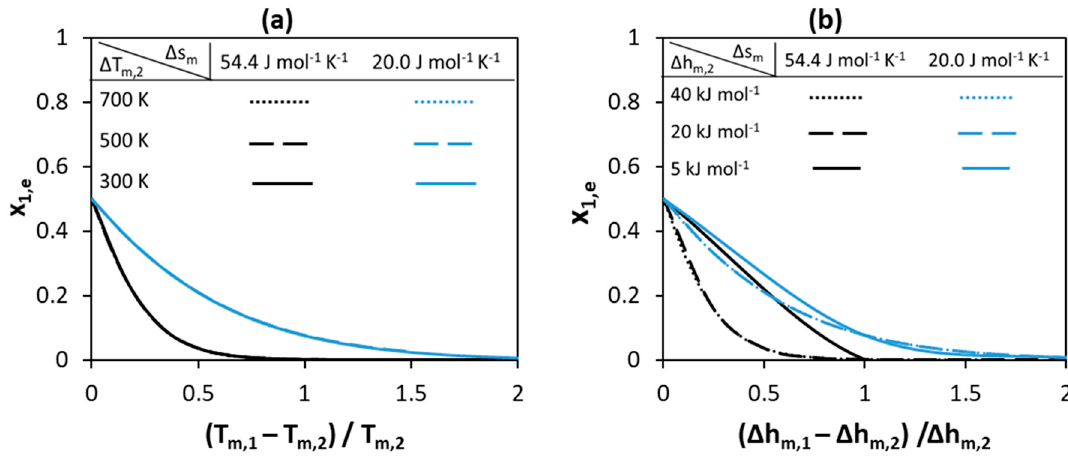
Figure 4. Effect of ( a ) melting temperature ( b ) melting enthalpy of pure components on the eutectic composition of Component 1.